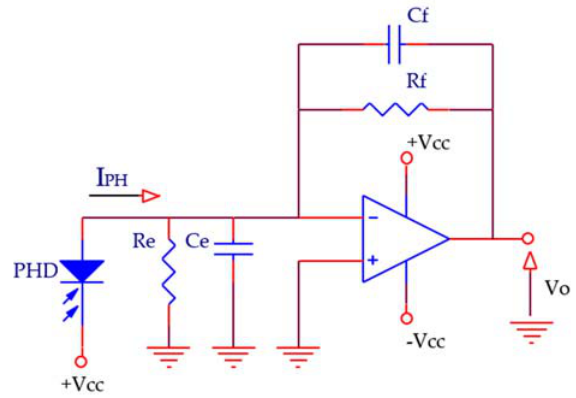
Figure 3. TIA model and equivalent input impedances (Re and Ce).